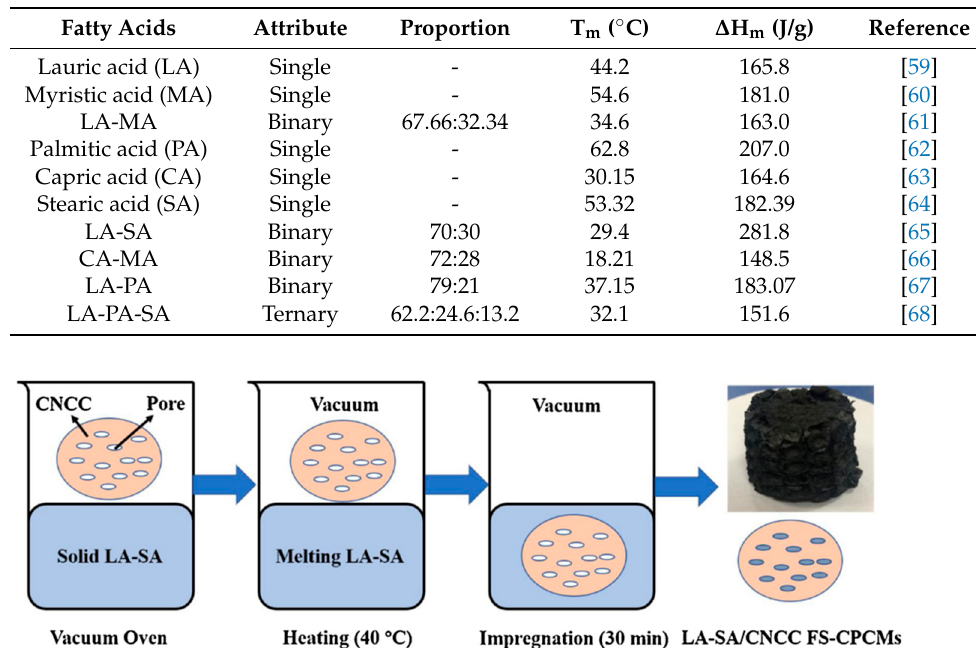
Figure 5. Preparation process of composite PCMs with carbonized corn cob and LA-SA [57].